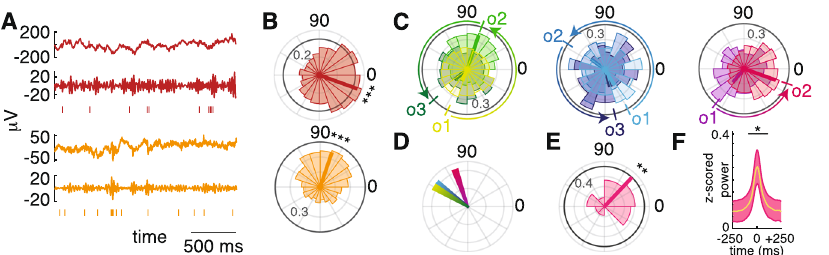
Fig.3|Consistent fi ringsequencesduringassemblyactivationmayresultfrom member neurons locking to different phases of the underlying gamma oscillation. A LFP (top),gammafrequency band activity(band-passed signalat 30 – 50Hz,fordisplayonly),andspikerasterfortwoexampleassemblymember neuronsdemonstrating signi fi cantphase locking to theunderlying gamma oscillation at 40Hz. B Circularhistogramsdemonstrating the probabilityden- sity withineachof the displayed phase binsfortwo examplesof 40Hz phase- locked assembly memberneurons.Colors indicate that the neuronswere iso- lated fromthe samerecordings as the signalsamplesdisplayed in ( A ).The dar- kenedlineisatanangleequaltothemedianphaseacrossallspikesandthelength isequaltothemeanresultantvectorlength. C Threeexamplesoftherelationship between fi ringorderandpreferredphaseofspikingalongtheunderlying40Hz oscillation.Phase histograms foreach gammaphase-locked assemblymember neuronforeachassemblyare superimposed.The medianphase and mean